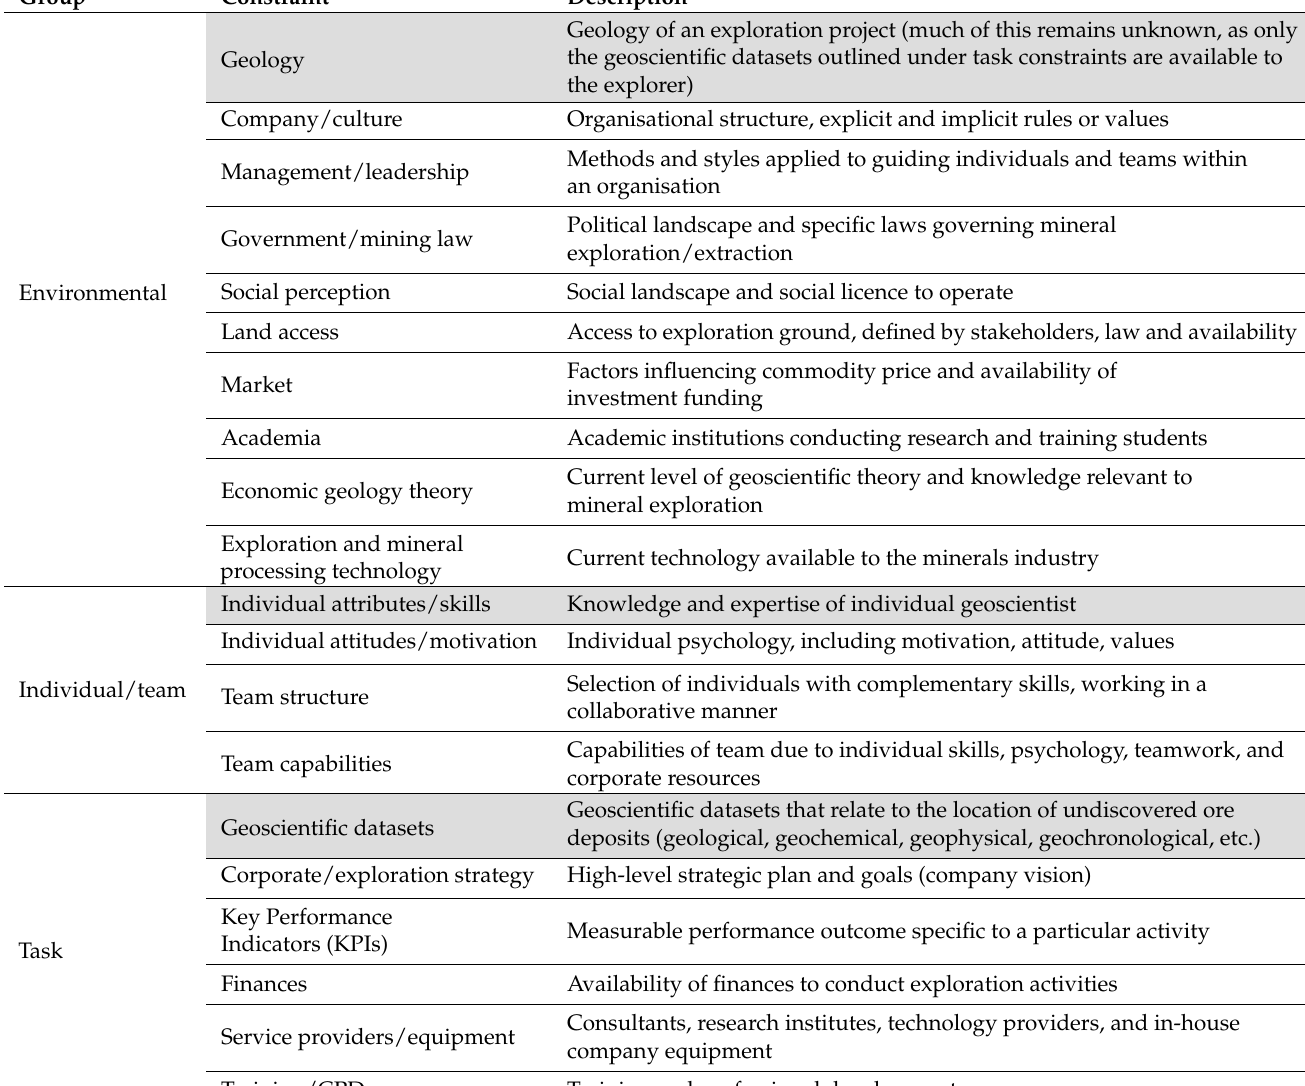
Table 1. Examples of constraints in mineral exploration